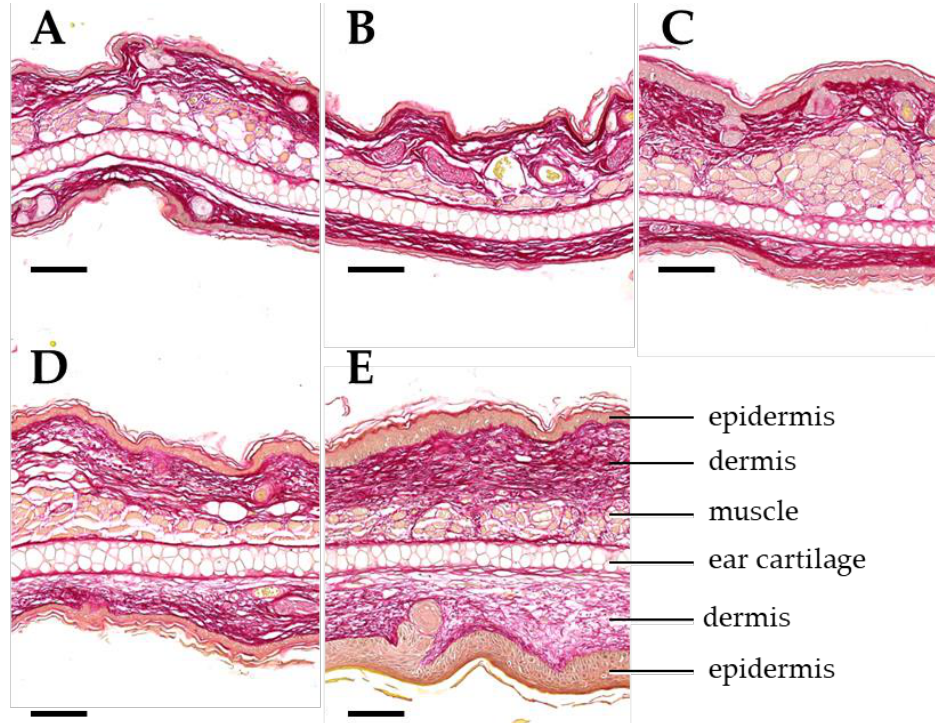
Figure 7. Dose-dependent development of dermal fibrosis. Representative images of ear sections on day 92 after a 4-fraction course using different doses per fraction: sham ( A ), 5 Gy ( B ), 10 Gy ( C ), 20 Gy ( D ), 30 Gy ( E ). Sections are stained with Sirius red for demonstration of collagenous connective tissue (dark red color). Important anatomical structures are indicated in E . Ear thickness and connective tissue deposition in the dermal layers of the ear skin increase with the radiation dose. Paraffin sections. Scale bar: 100 µm.